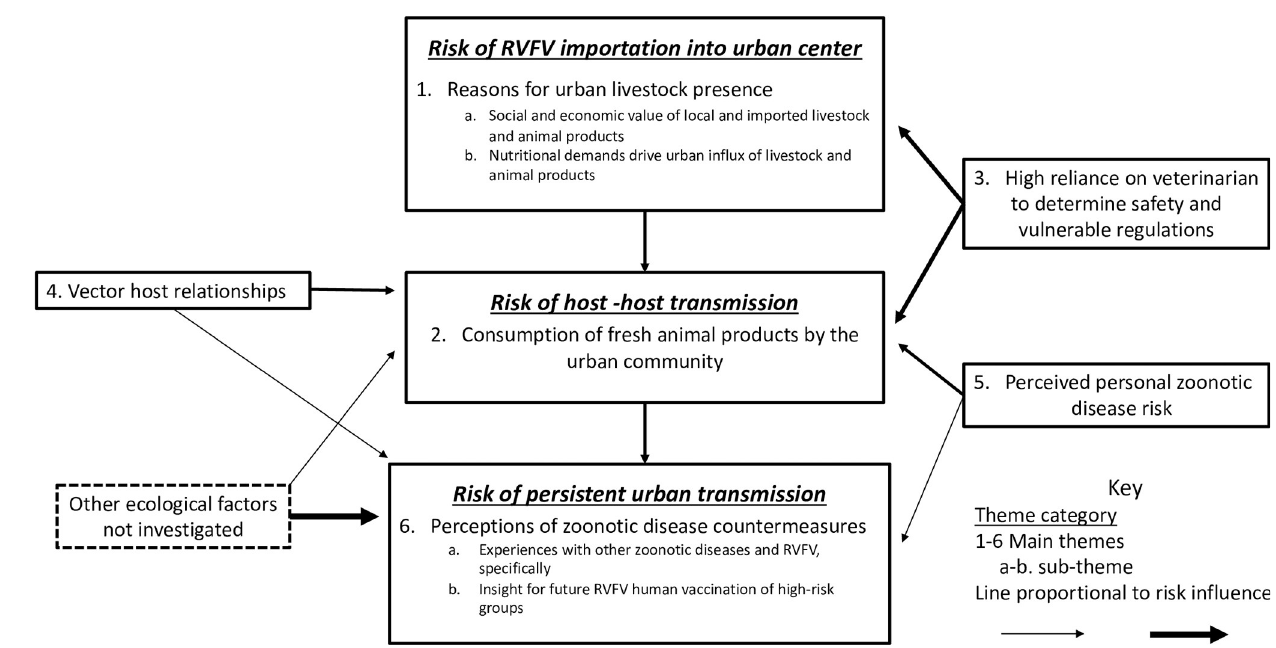
Fig 2. Theoretical framework for influences of urban RVFV risk pathways for introduction, transmission, and persistence.